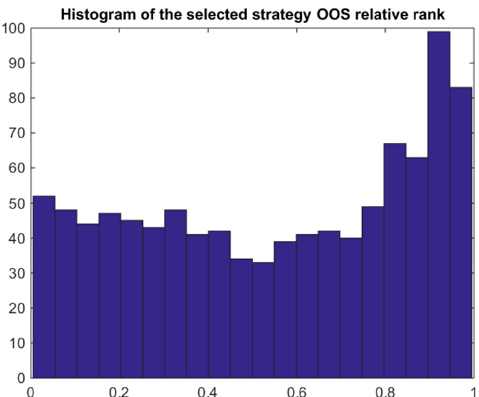
Figure 8. Stationary bootstrap simulation Sharpe ratio and the mean return ex ante (blue) and ex post (red) probability densities.